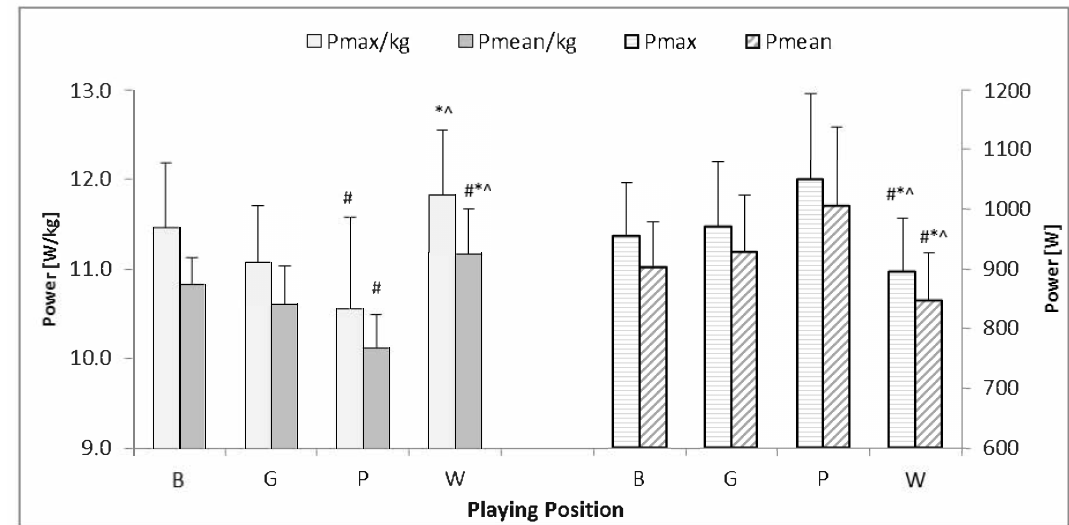
Figure 1. Di ff erences in absolute maximal power (P max ) and mean power (P mean ) as well as relative maximal power (P max / kg ) and mean power (P mean / kg ) in the RSA test for athletes of various playing positions. B—backs, G—goalkeepers, P—pivots, W—wings, #—significantly di ff erent from B, *—significantly di ff erent from G, ˆ—significantly di ff erent from P.